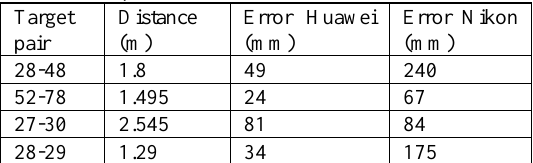
Table 1. Comparison of errors on scale